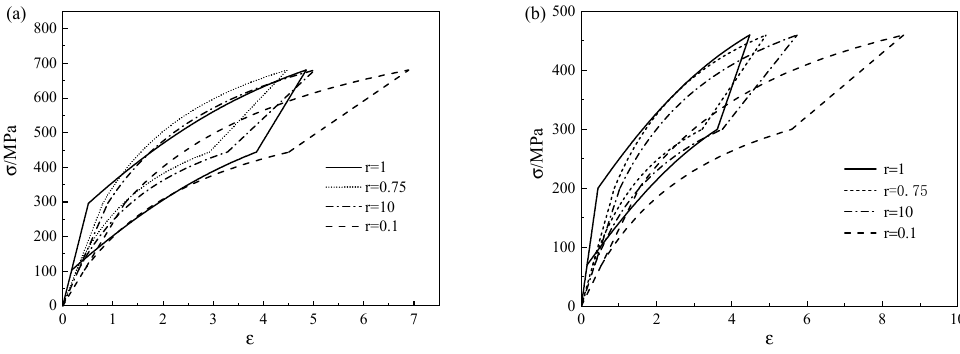
Figure 6. Stress–strain curves of different aspect ratios with porosities of ( a ) 13% and ( b ) 25%. When the pore shape is determined, the stress–strain curves of SMA with different porosities are shown in Figure 7. It can be seen from Figure 7 that with the increase in porosity, the phase transformation stresses of the porous SMA gradually decreased, the hysteretic curve gradually moved down and shrank, and the degree of change was the largest when r = 0.1 .